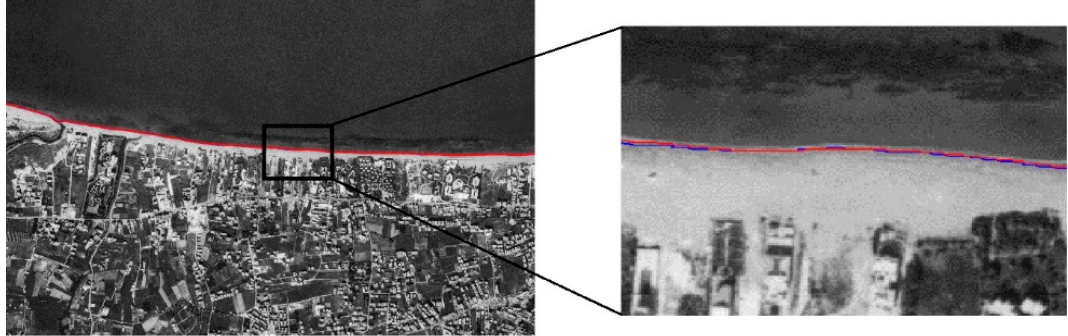
Figure 10. Estimation of the coastline and a close-up of the coastline area, applied on another aerial image.